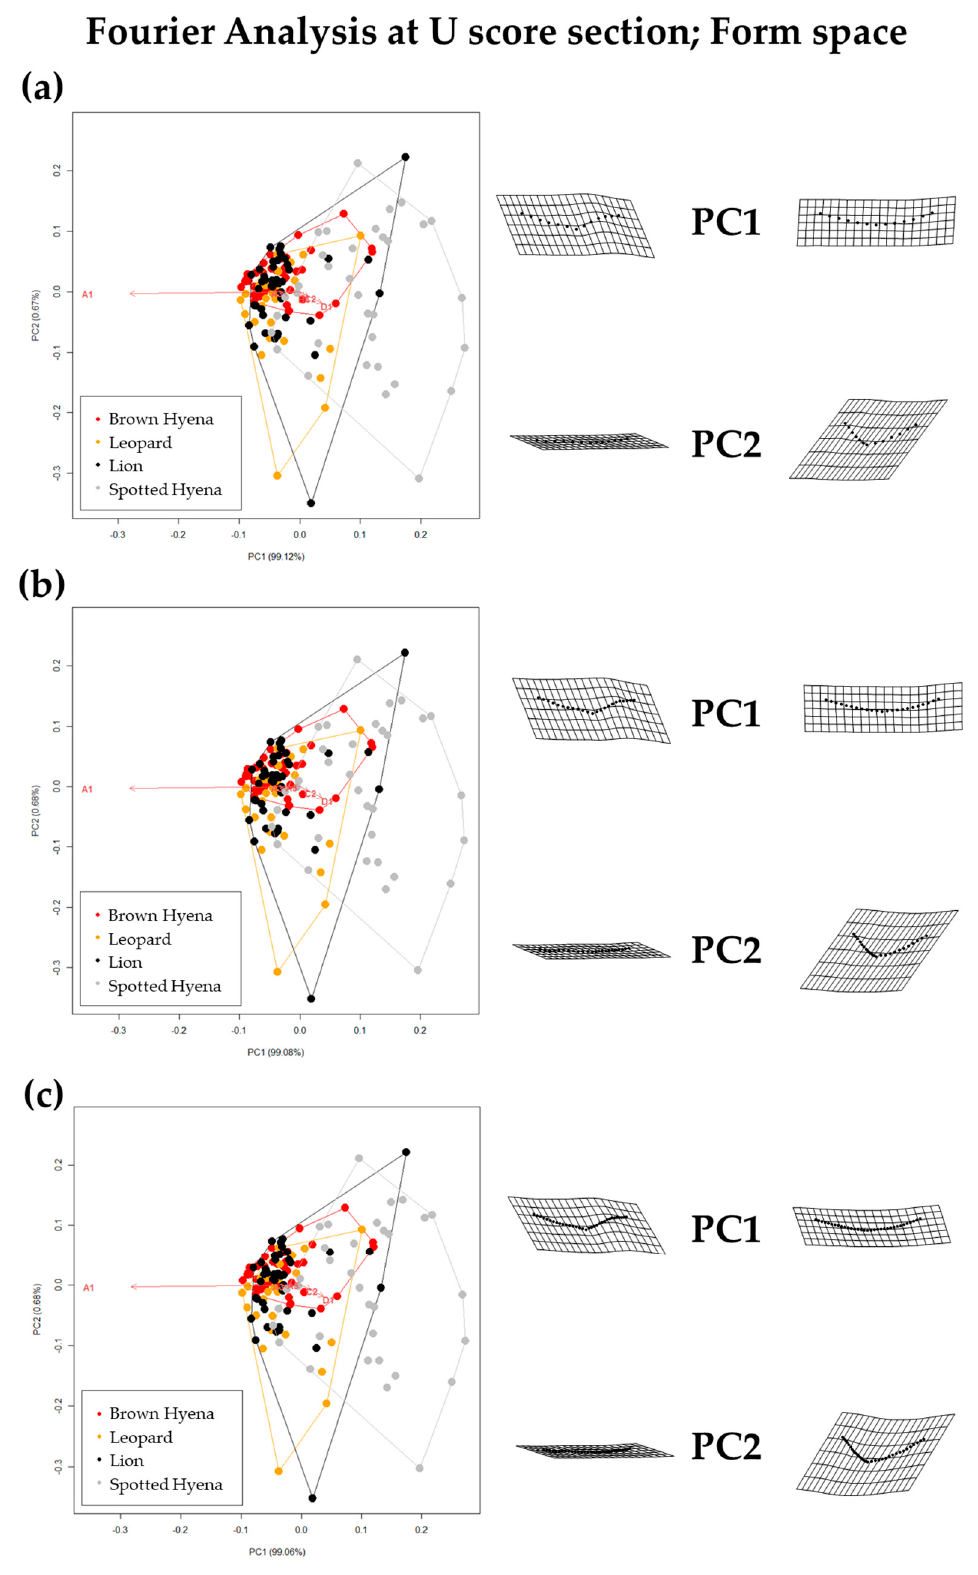
Figure 8. Form PCA plots on Elliptic Fourier Analysis on the 2-curves semilandmark models at the most conspicuous U score section, using ( a ) 13 points; ( b ) 23 points; and ( c ) 33 points. Extreme changes in form along PC1 and PC2 are illustrated with the aid of transformation grids. Optimal harmonics for each model are ( a ) 4; ( b ) 6; and ( c ) 6.